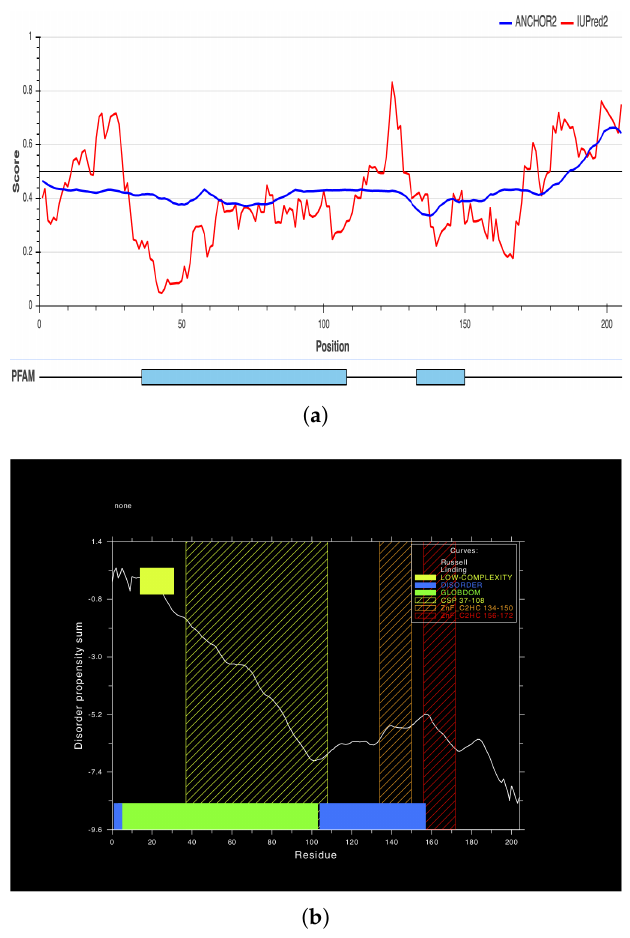
Figure 10. ( a ) Prediction of the binding regions of the cLin-28 protein. ( b ) The globular and disordered regions in the cLin-28